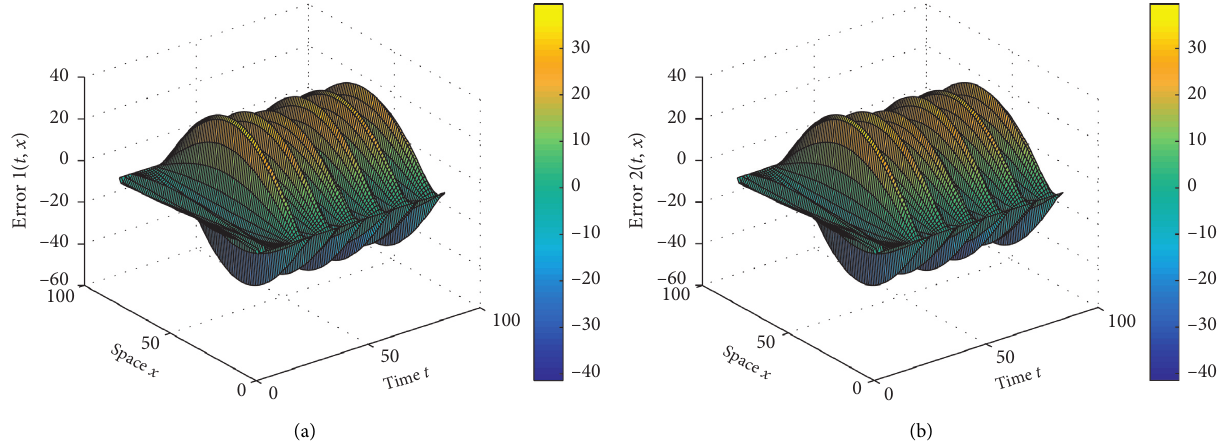
Figure 5: Synchronization errors between systems (46) and (47), with no controller.